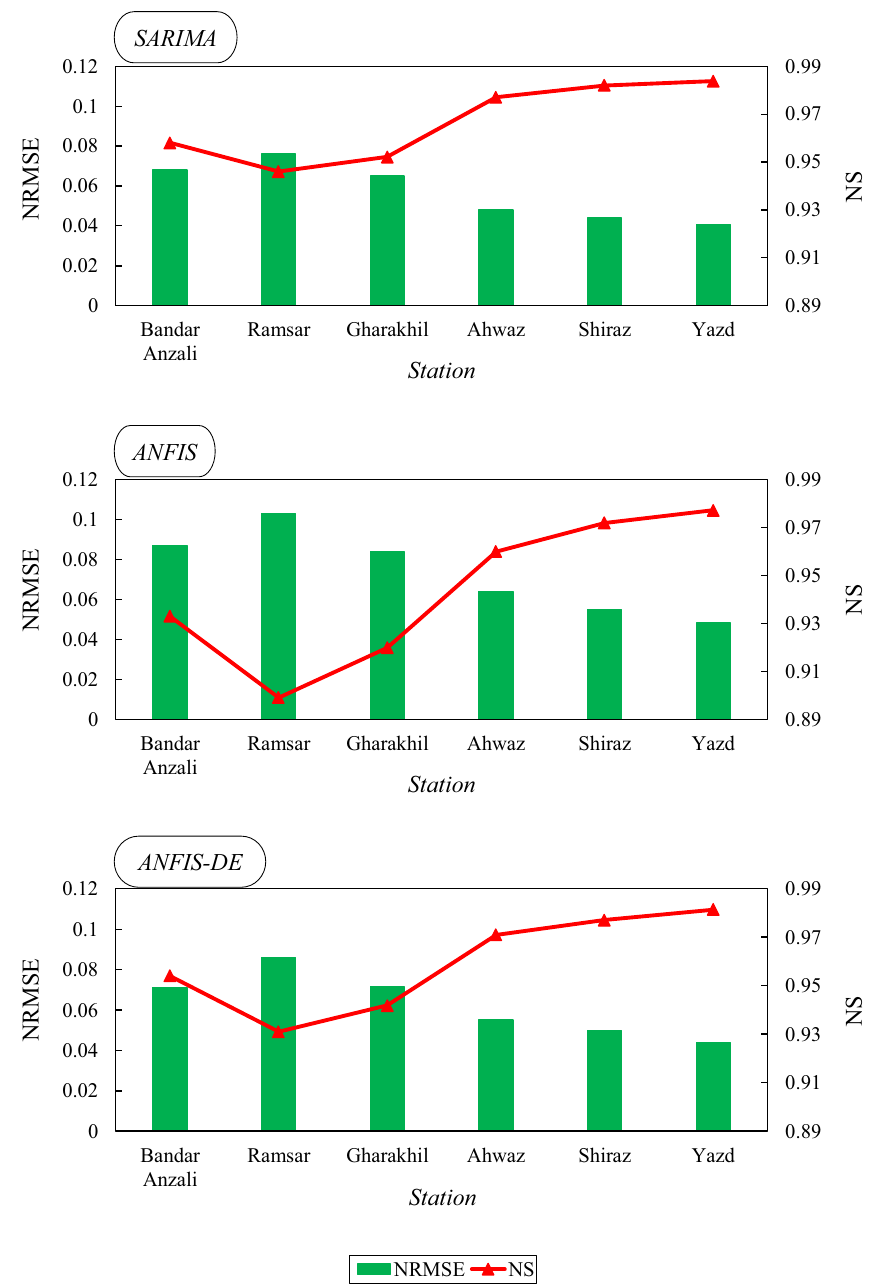
Figure 8. Combo-graph of NRMSE and NS criteria to make a comparison between the different